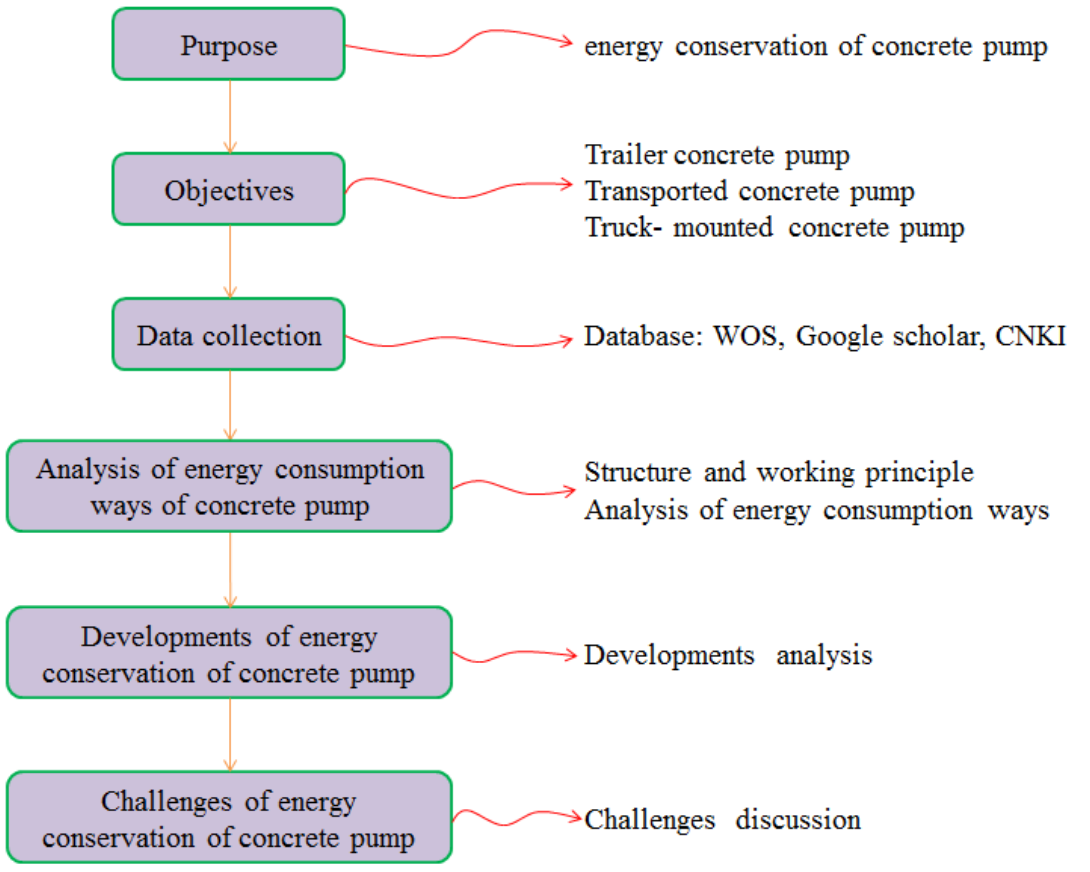
( c ) Figure 2. Three types of concrete pumps. ( a ) Trailer concrete pumps [27]. ( b ) Transported concrete pumps [28]. ( c ) Truck-mounted concrete pumps [29]. As shown in Figure 3, trailer concrete pumps mainly consist of an engine, a hydrau- lic pump, control valves, a main system and auxiliary system. The main system including a pumping system, oscillating system and agitating system is used to realize pumping concrete. The auxiliary system including outrigger system, cleaning system, lubrication system and cooling system is used for the maintenance of the concrete pump.